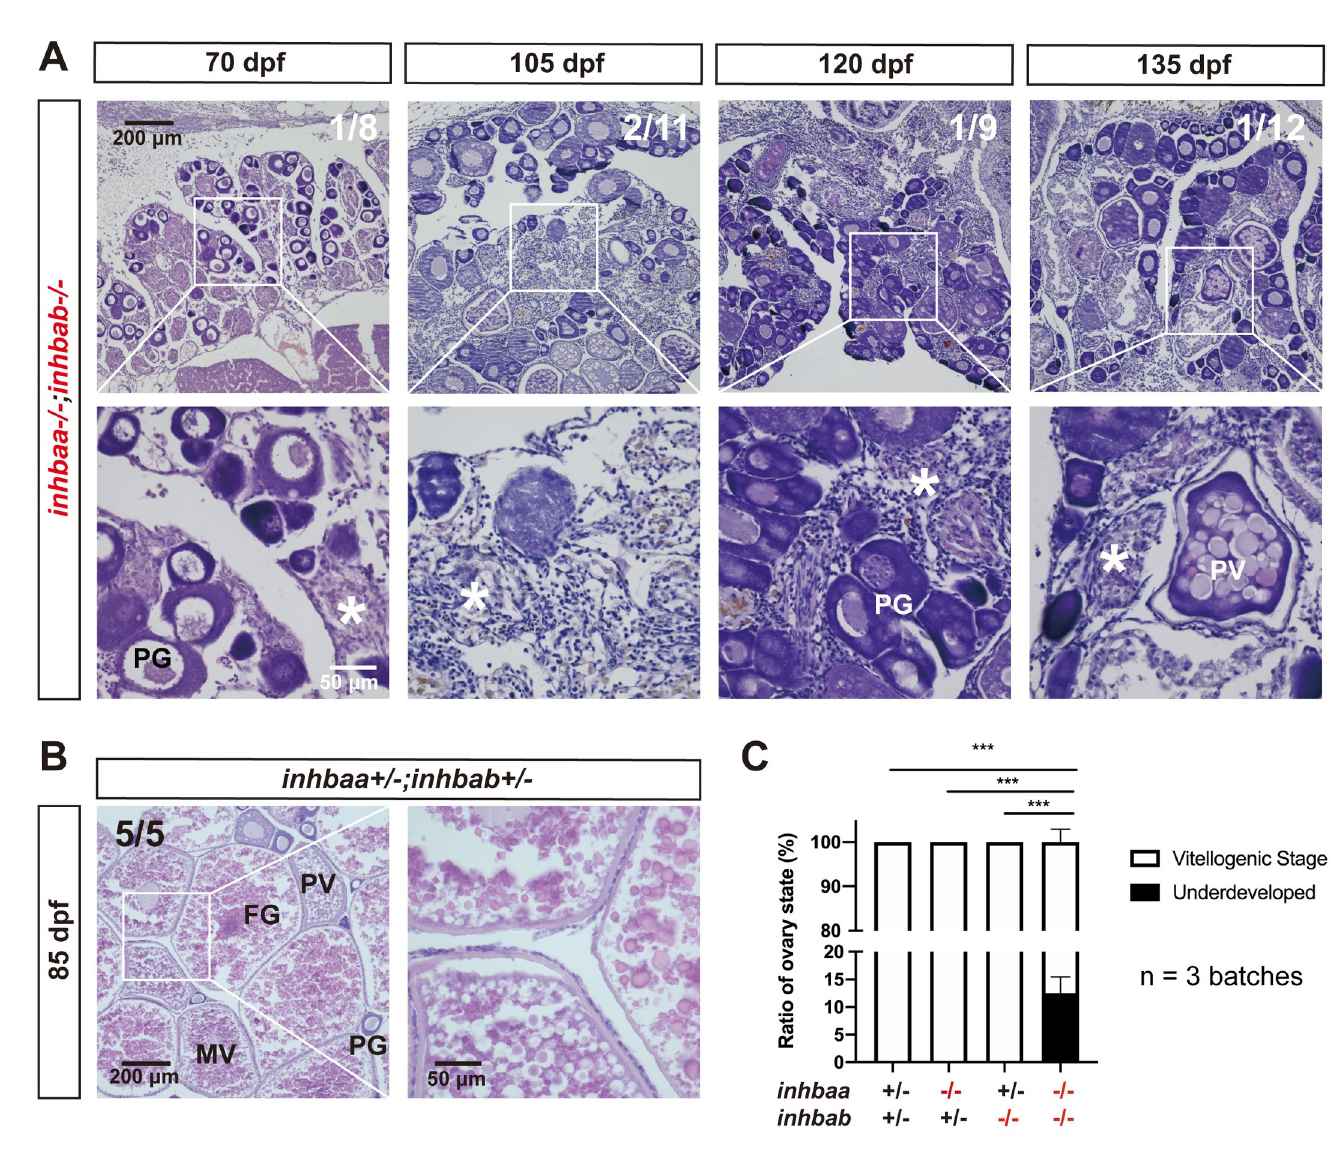
Fig 6. Failure of follicle activation and defective folliculogenesis in activin β A double mutant ( inhbaa -/-; inhbab -/-). (A) Ovary of some mutant individuals (~10%) at 70–135 dpf. The ovary contained PG follicles only at 70 dpf, and much of the inter-follicular space was filled with abundant stromal cells. At later development stages (105, 120 and 135 dpf), PV follicles could occasionally be observed; however, there were no vitellogenic follicles and the ovaries were mostly occupied by over-proliferated stromal cells. The boxed areas are shown at higher magnification below. The numbers shown in the photos indicate the total number of fish examined (lower) and the fish exhibiting similar phenotype to that shown (upper). (B) Ovary in the control fish ( inhbaa +/- ;inhbab +/-)at 85 dpf. Vitellogenic follicles developed normally in the control. (C) Statistical analysis of ovarian types from 105 to 135 dpf ( ��� p < 0.001; n = 3 batches). PG, primary growth; PV, previtellogenic; MV, mid-vitellogenic; FG, full-grown; asterisk, infiltrating stromal